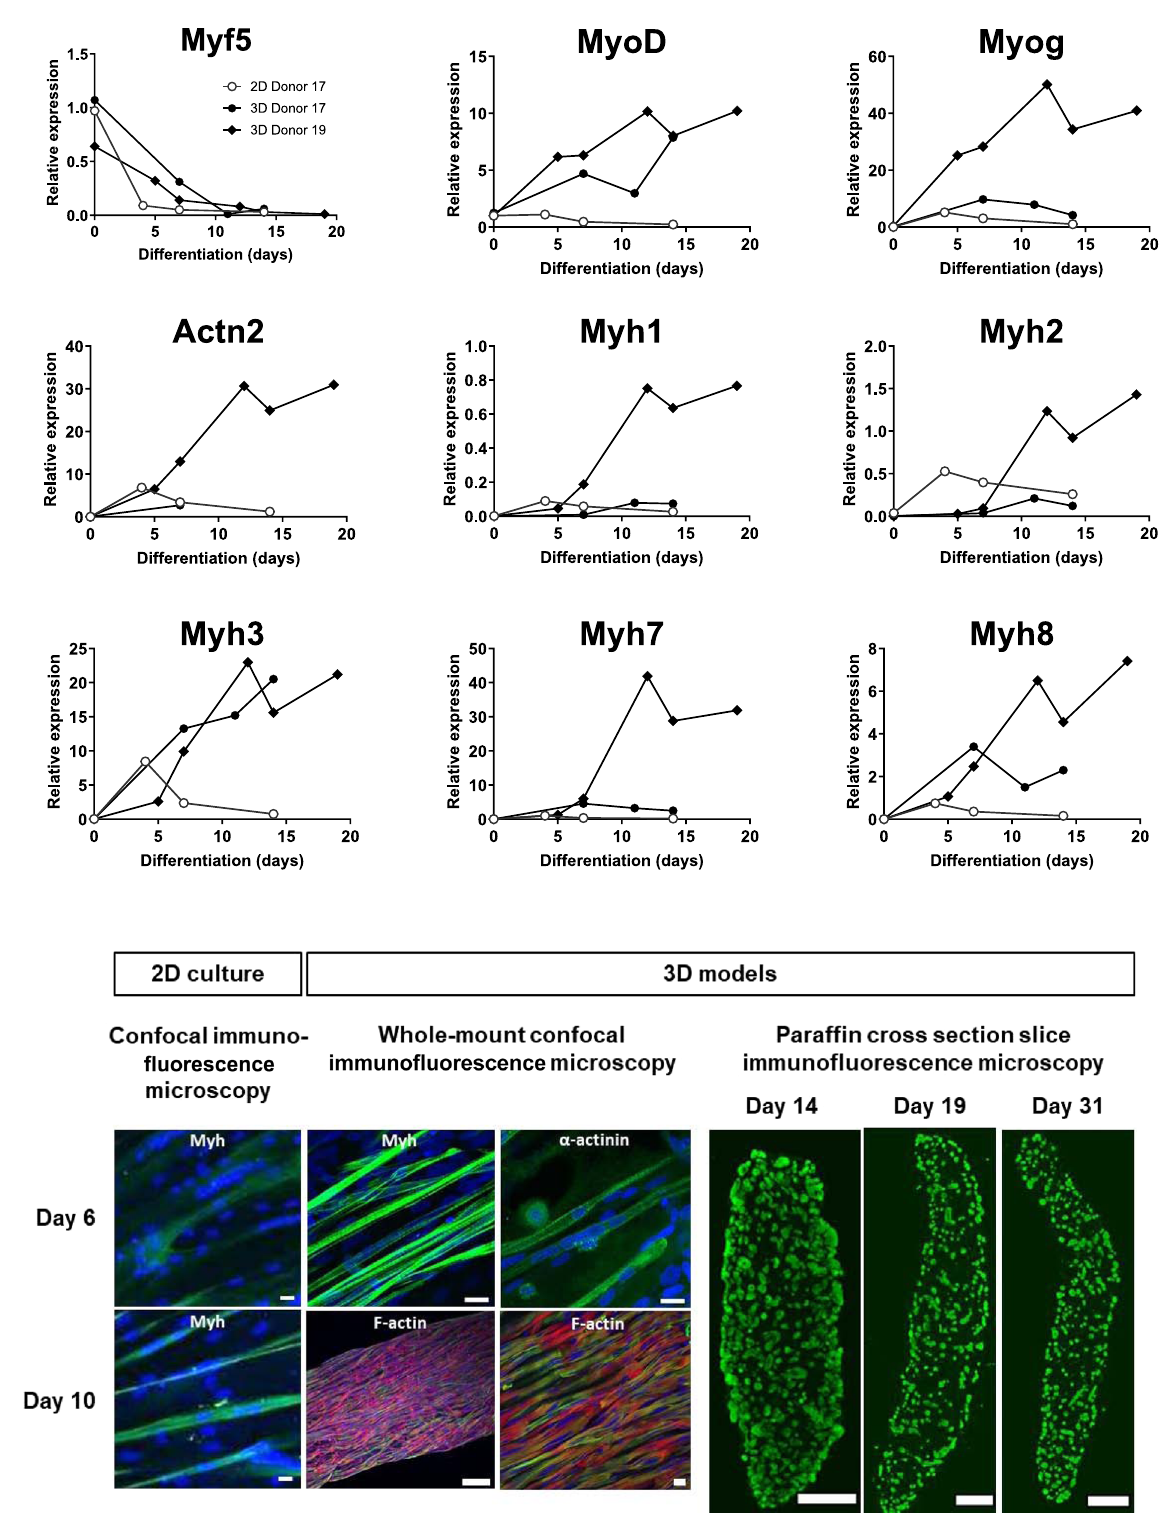
skeletal-troponin complex, which slows calcium release. Addition of 20 µM Tirasemtiv enhanced EPS-induced contractile force within a few minutes to a sustained level for up to 30 min (Fig. 6b). In contrast, solvent control (0.2% DMSO) did not lead to signi fi